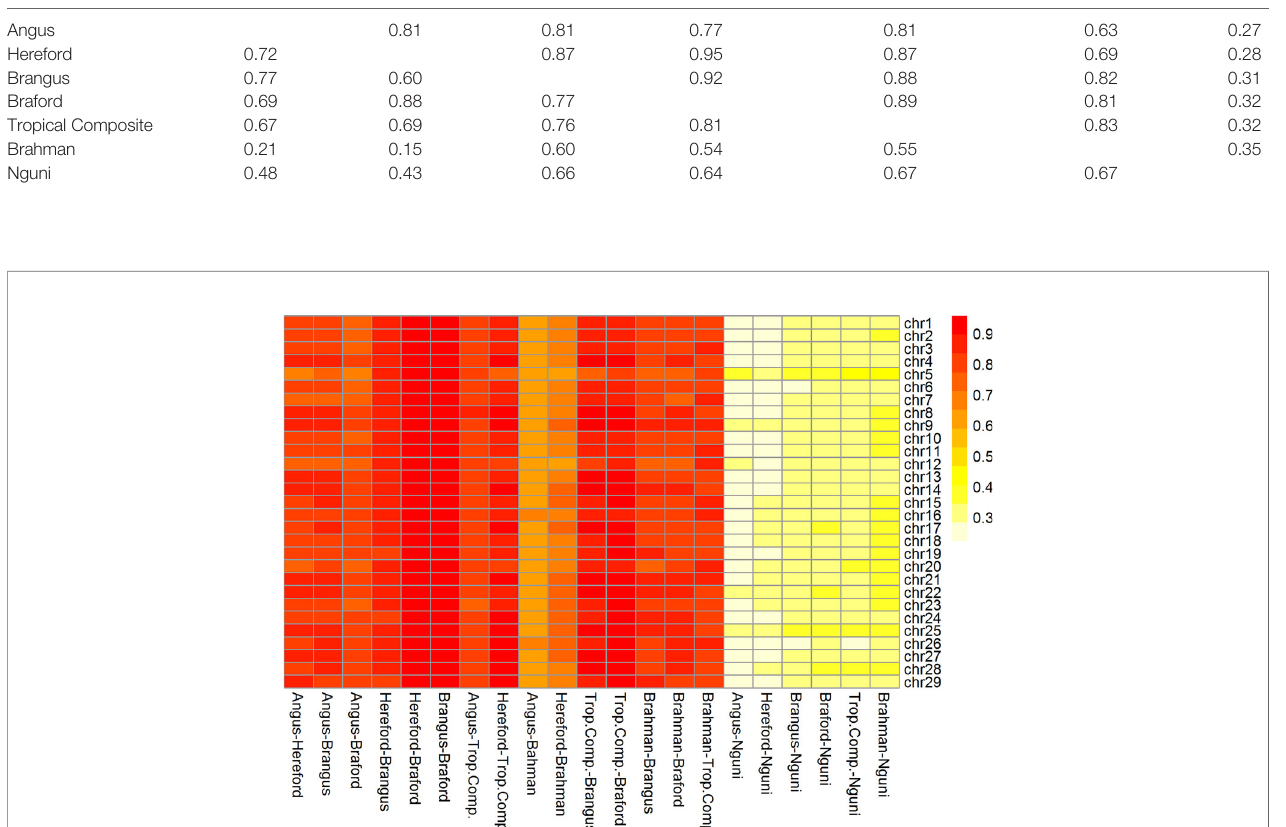
TABLE 2 | Average persistence of phase for adjacent markers(above the diagonal) andcorrelation ofallelefrequencies (below the diagonal)between different populations. Population